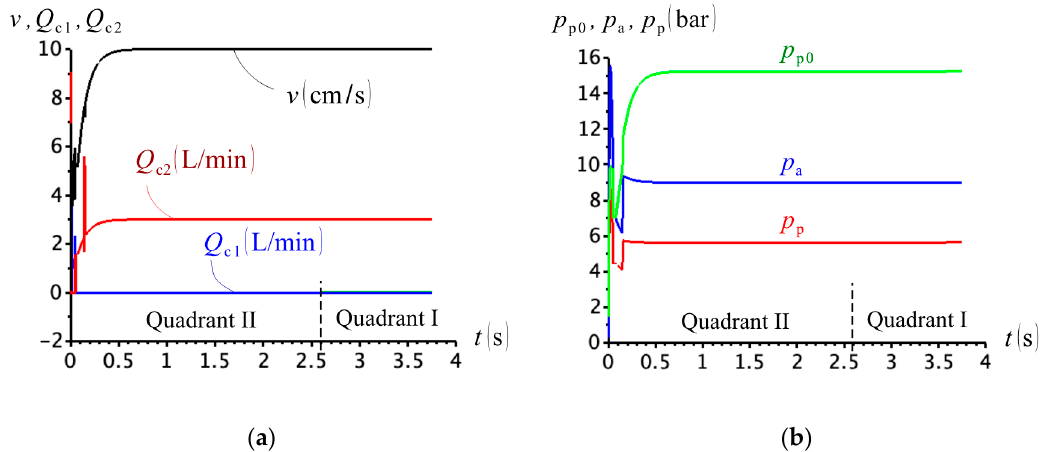
Figure 14. ( a ) Cylinder velocity and check valve flows; ( b ) circuit pressures ( m = 0.5 kg ) .